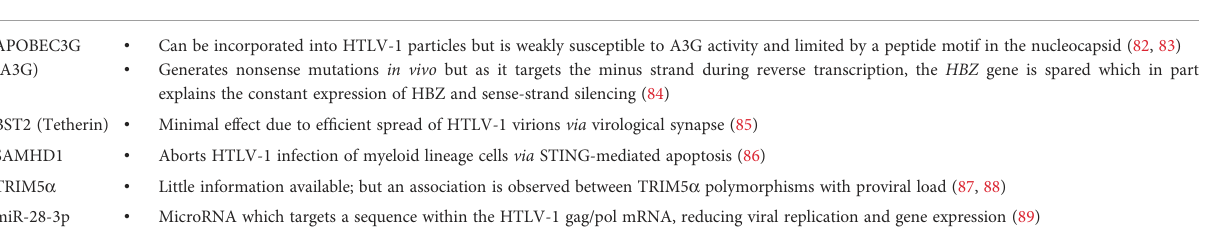
TABLE 1 Restriction factors and their impact on anti-HTLV-1